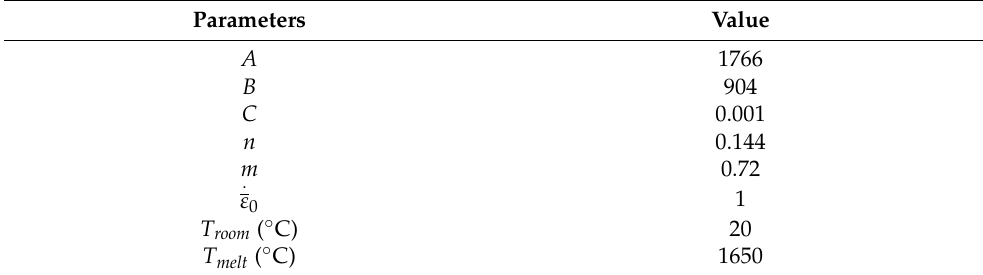
Table 3. Relevant parameters of the J-C